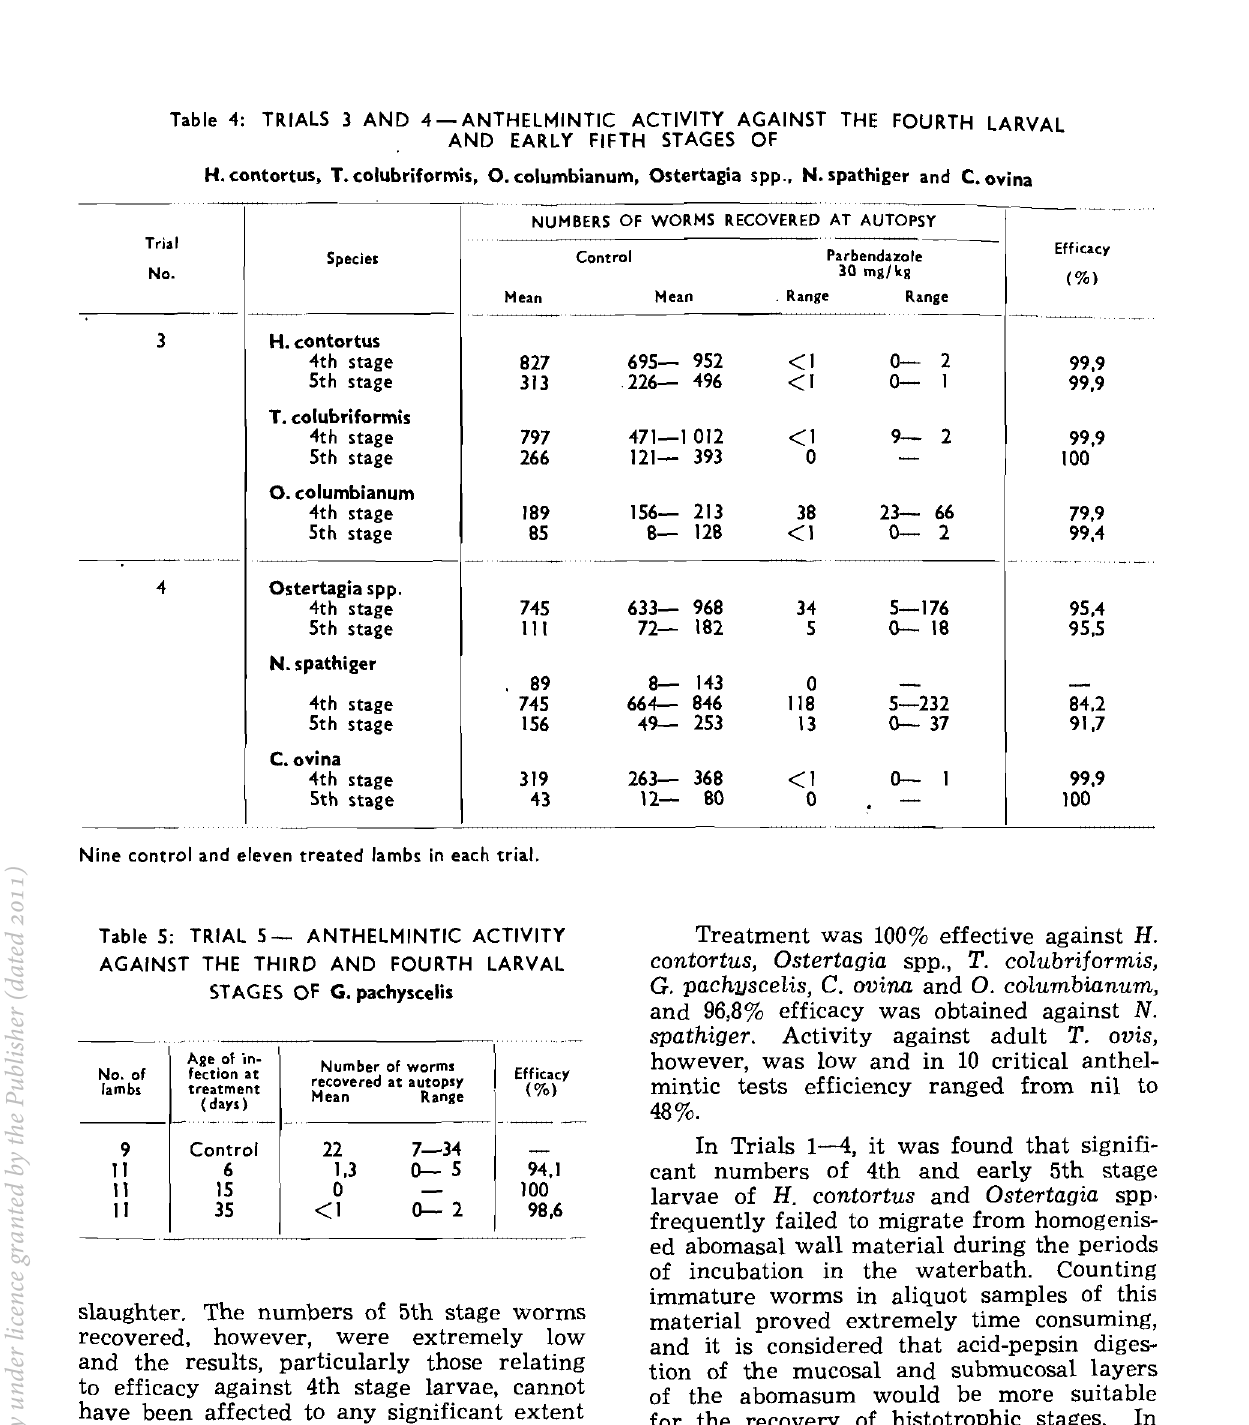
Table 4: TRIALS 3 AND 4-ANTHELMINTIC ACTIVITY AGAINST THE FOURTH LARVAL AND EARLY FIFTH STAGES OF H. contortus, T. colubriformis, O. columbianum, Ostertagia spp., N. spathiger and C.ovina